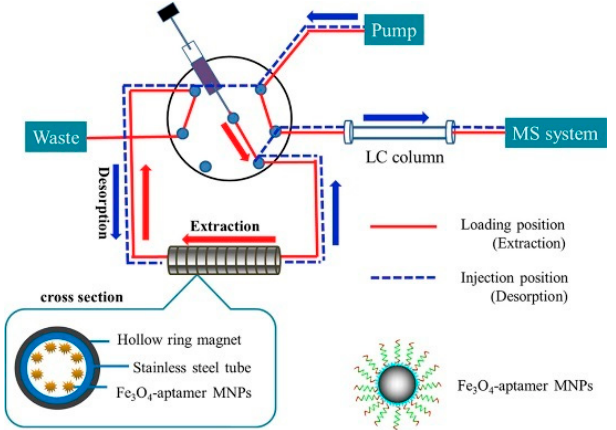
Figure 13. An aptamer-based online magnetic solid phase extraction for HPLC–MS analysis of o 8 dGuo. Reprinted with permission from Reference [45]. © 2018, Elsevier.